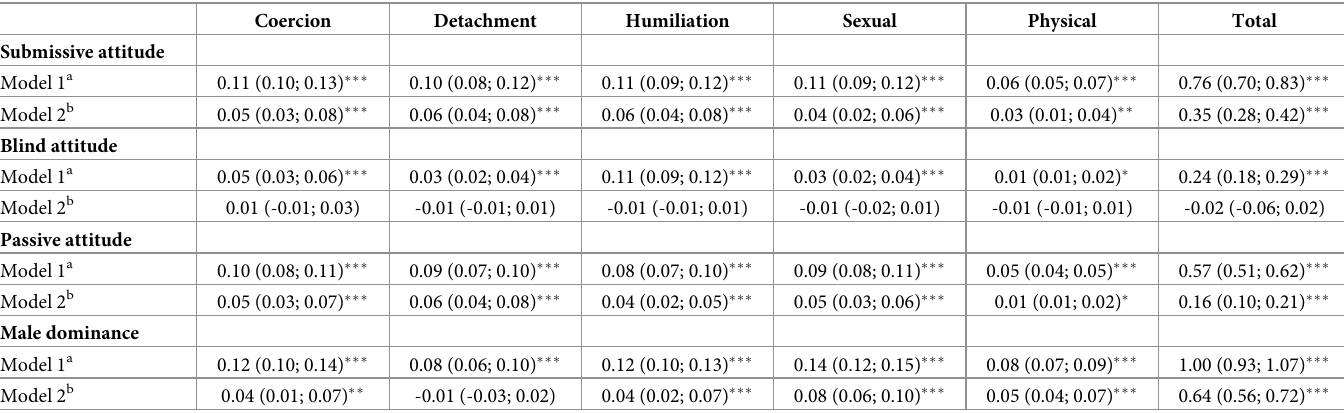
IPV: Intimate partner violence; GR: Gender role; CI: Confidence intervals. a Model 1 adjusted for age, degree, age of the first sexual relationship, number of partners, continuity with the relationship and family history of IPV. b Model 2 additionally adjusted for the complementary GR.